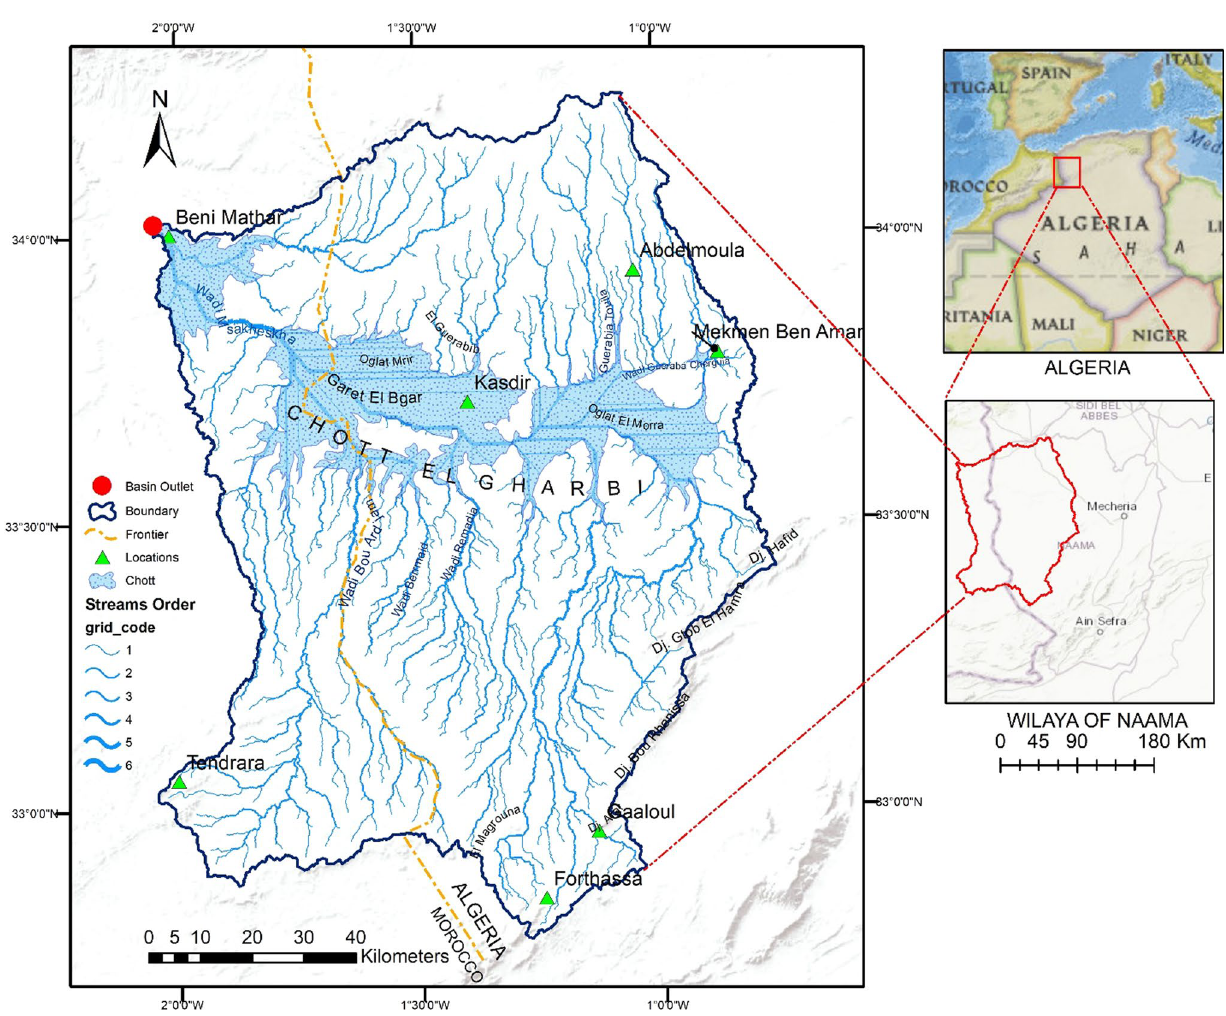
Fig. 1 Location map of